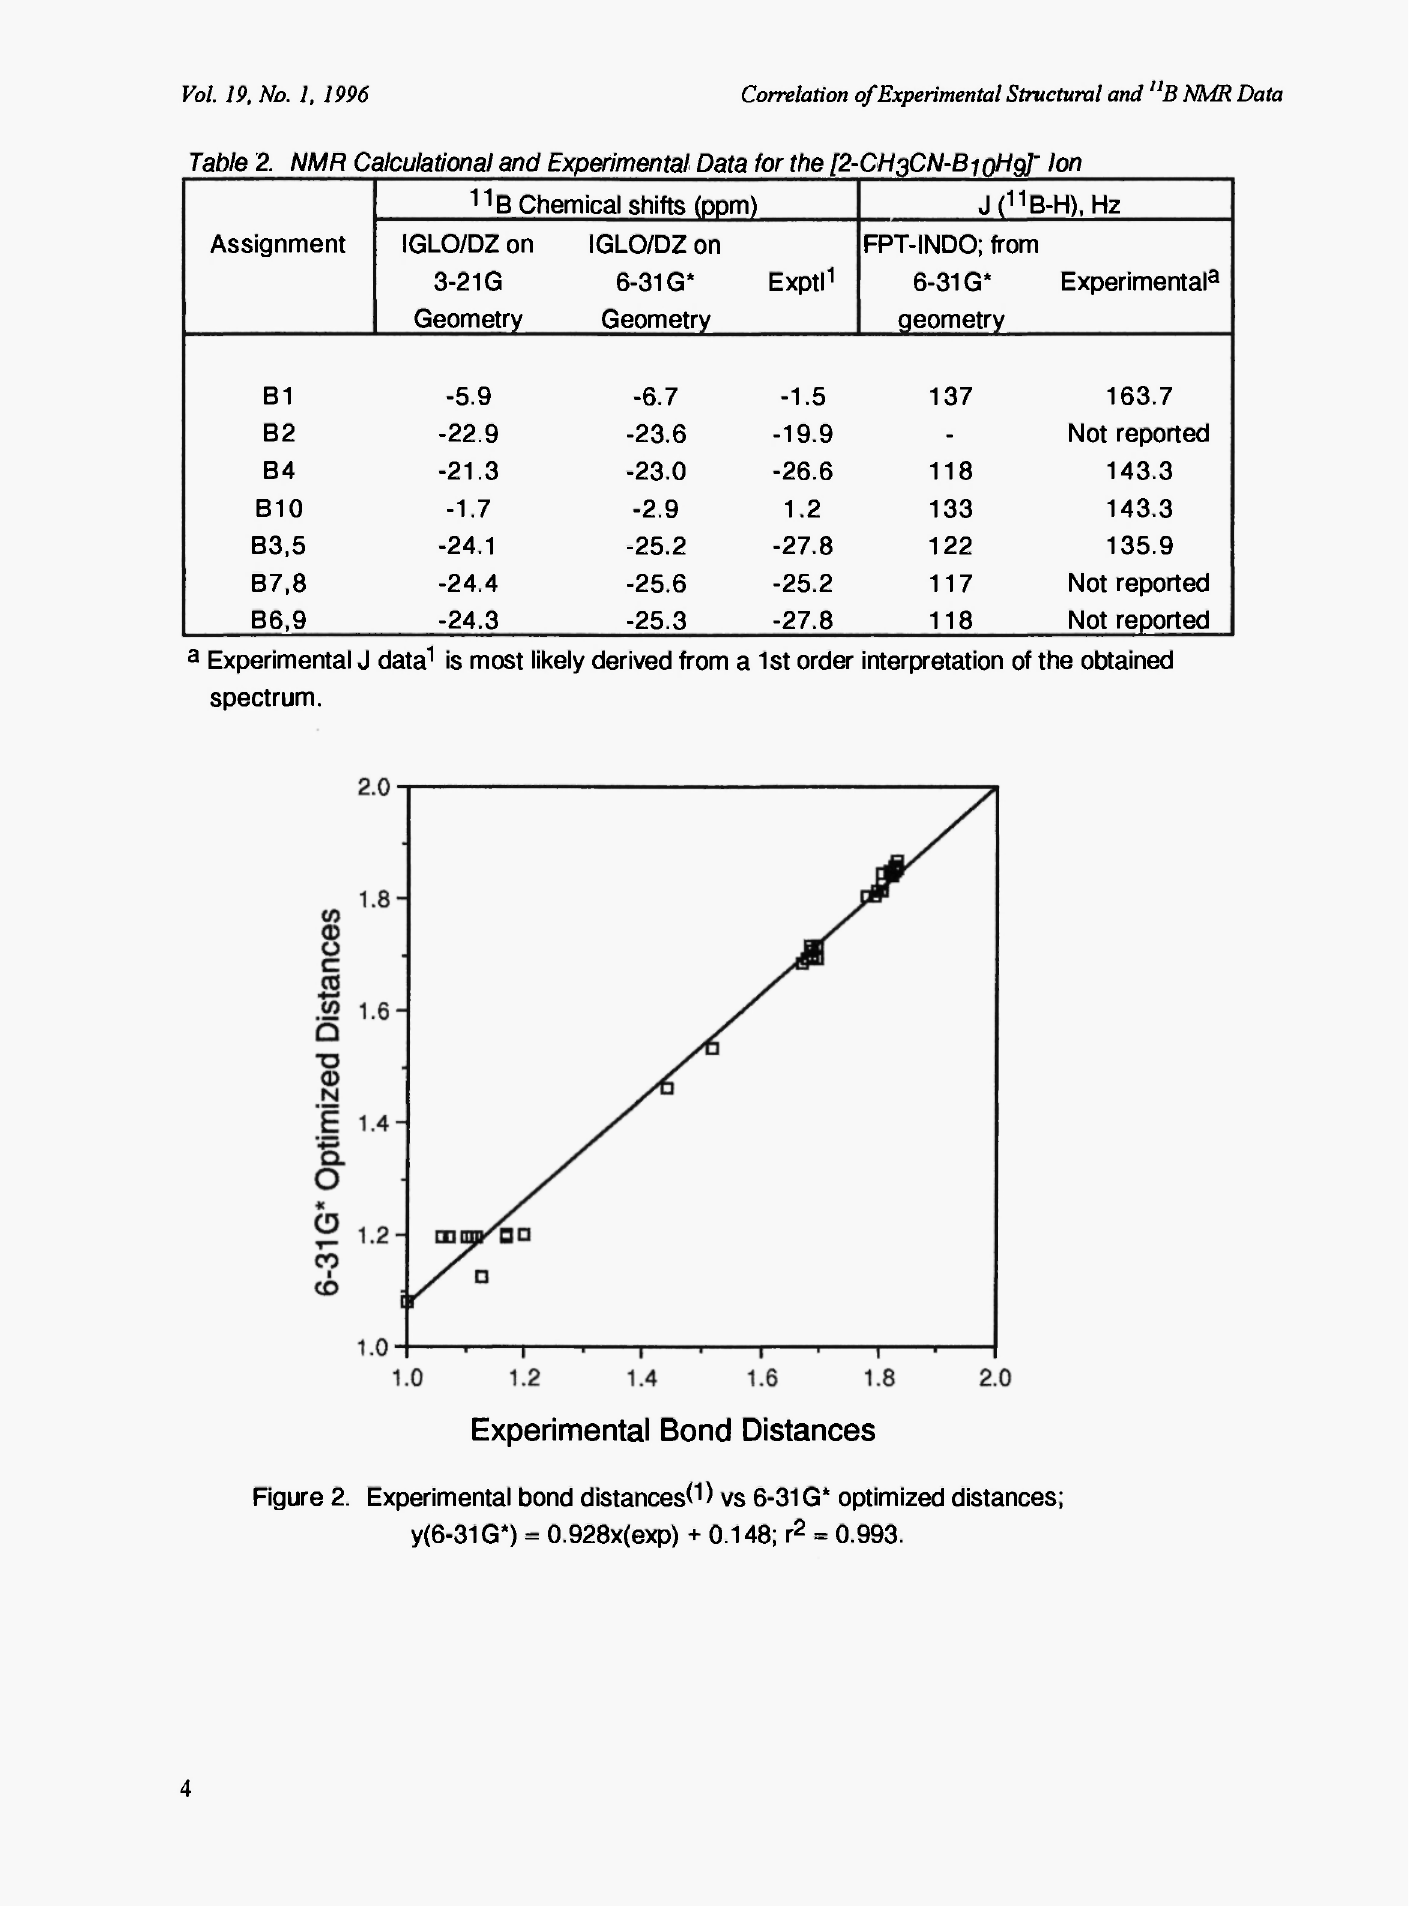
Table 2. NMR CalculationsI and Experimental Data for the [2-CH3CN-B10H9]- Ion 11 B Chemical shifts (ppm)